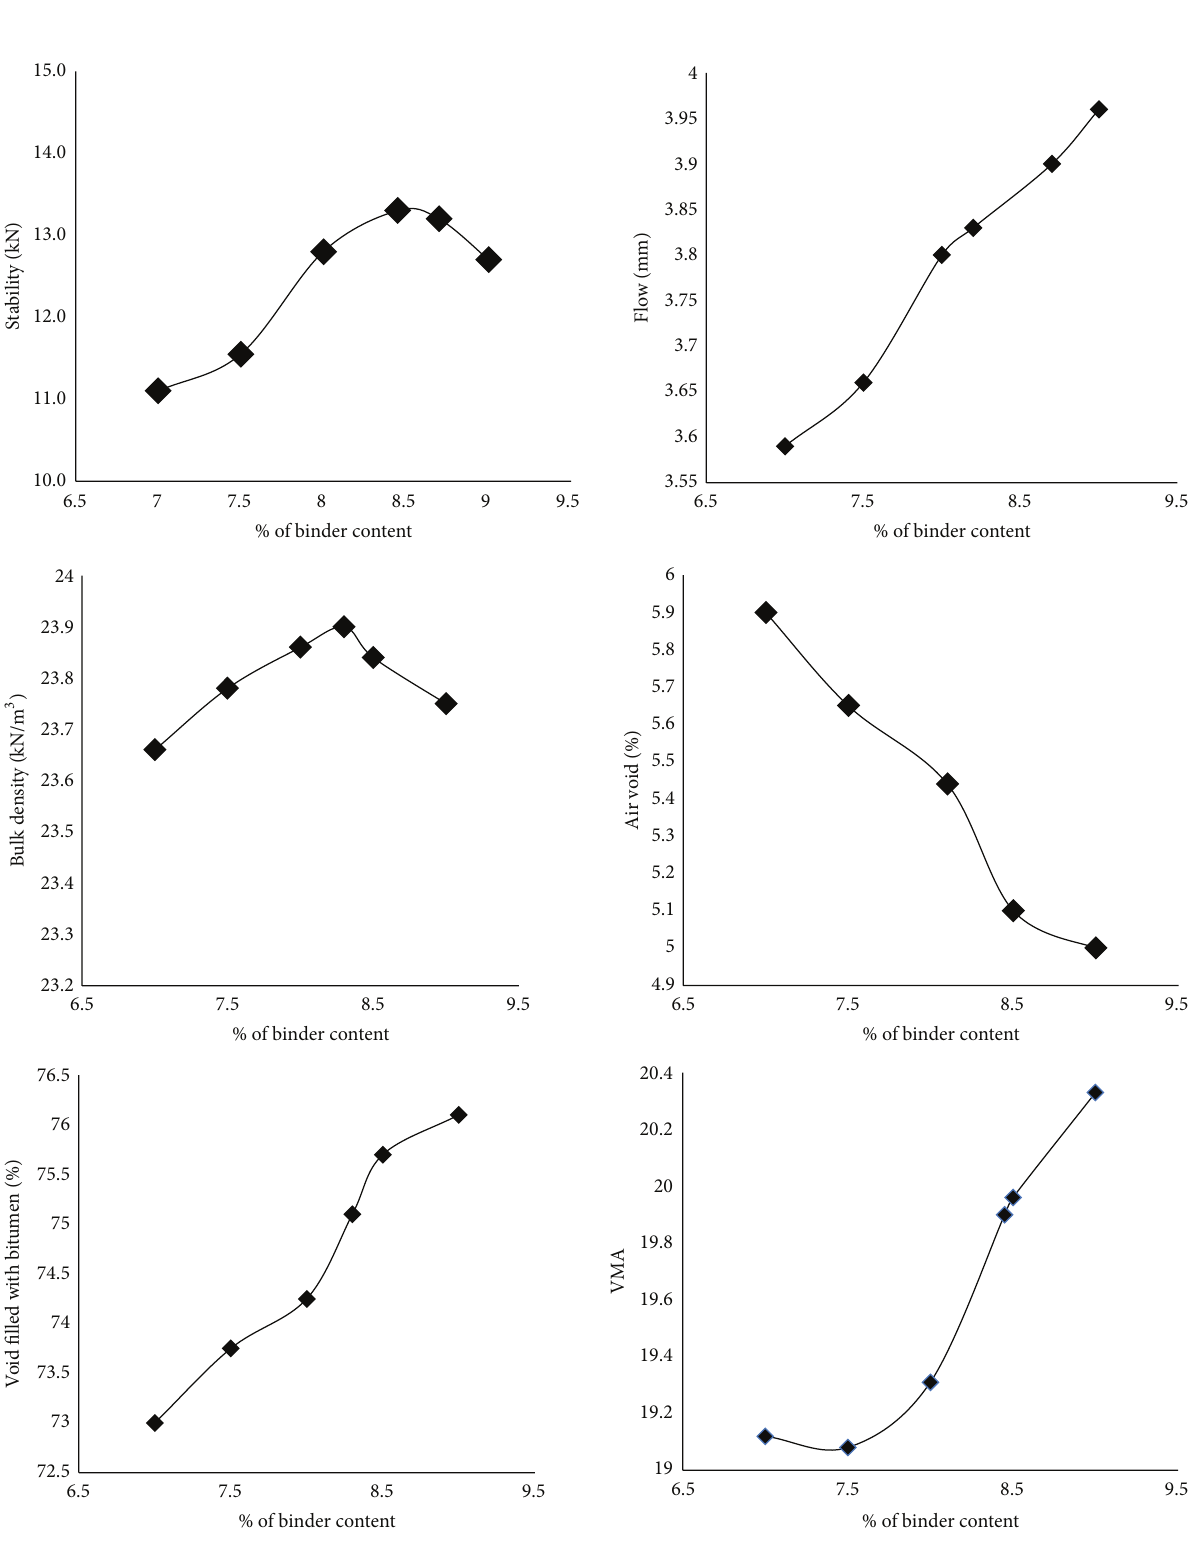
Figure 1: Volumetric properties of bituminous concrete mix (using 0.54% plastic coated OBBA) at binder content versus stability, flow, air voids, bulk density, voids filled with bitumen, and void in mineral